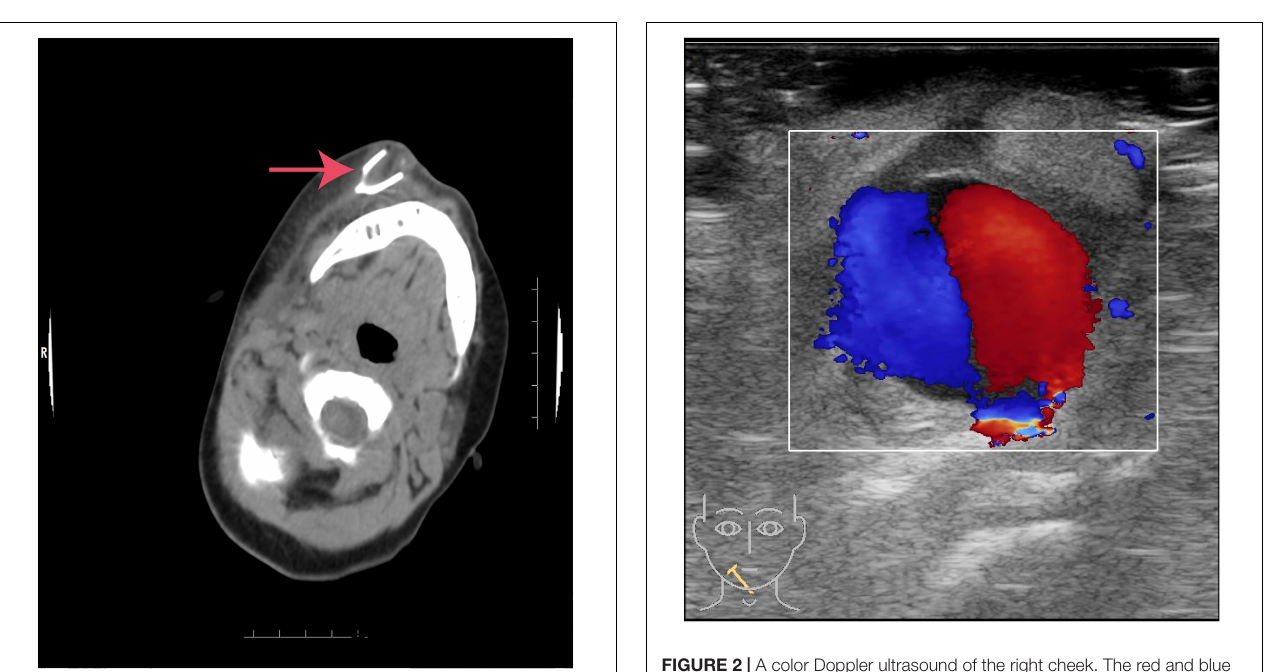
FIGURE 2 | A color Doppler ultrasound of the right cheek. The red and blue blood flow signals are shown as “yin and yang sign”.